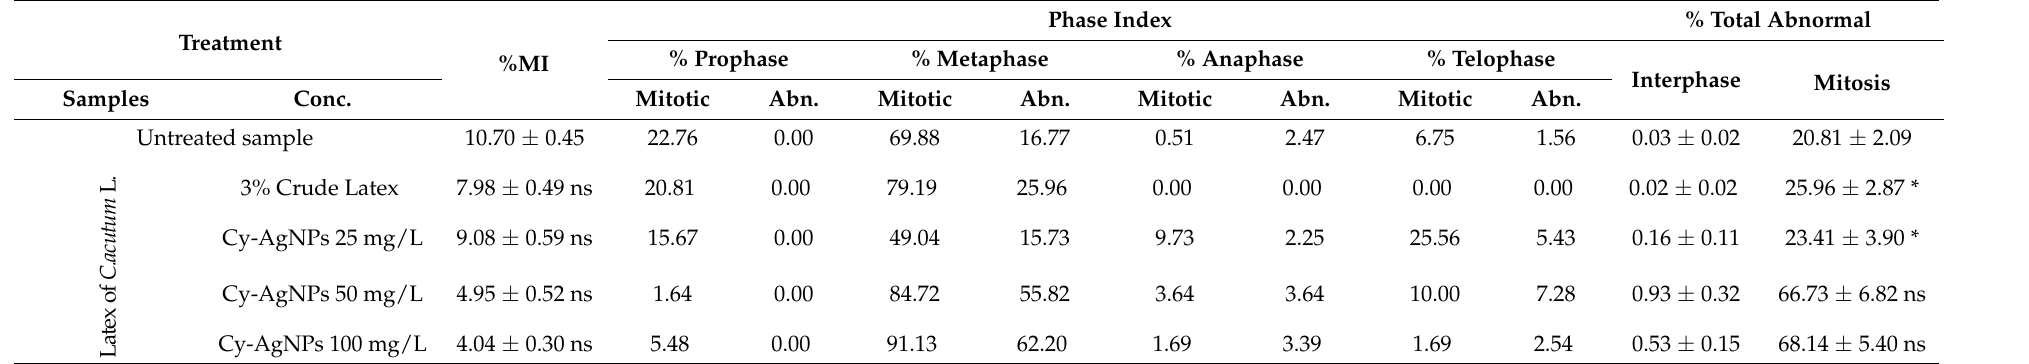
Table 2. Percentage of total abnormalities, normal and abnormal phase indices, and mitotic index for the treated V. faba root tips with 3% C. acutum latex and different concentrations of its silver